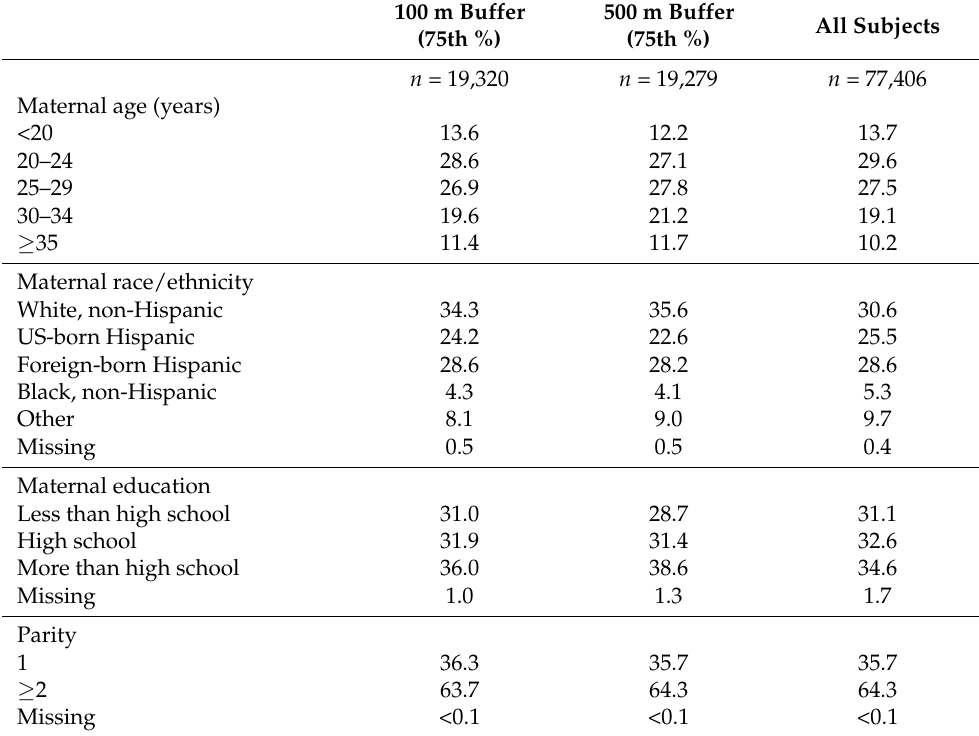
Table 2. Characteristics of participants (%) a by Greenspace (average NDVI) in the highest quartile of residential buffers in California from 2000 to